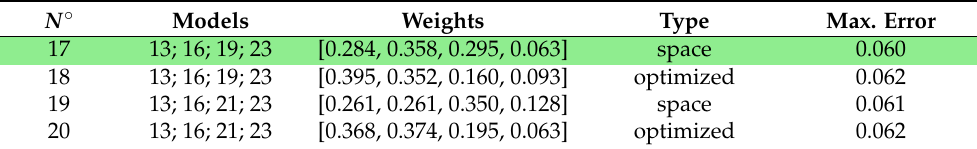
Table 12. Ensemble models tested using four single models and the maximum error obtained. Green row is the ensemble model selected.